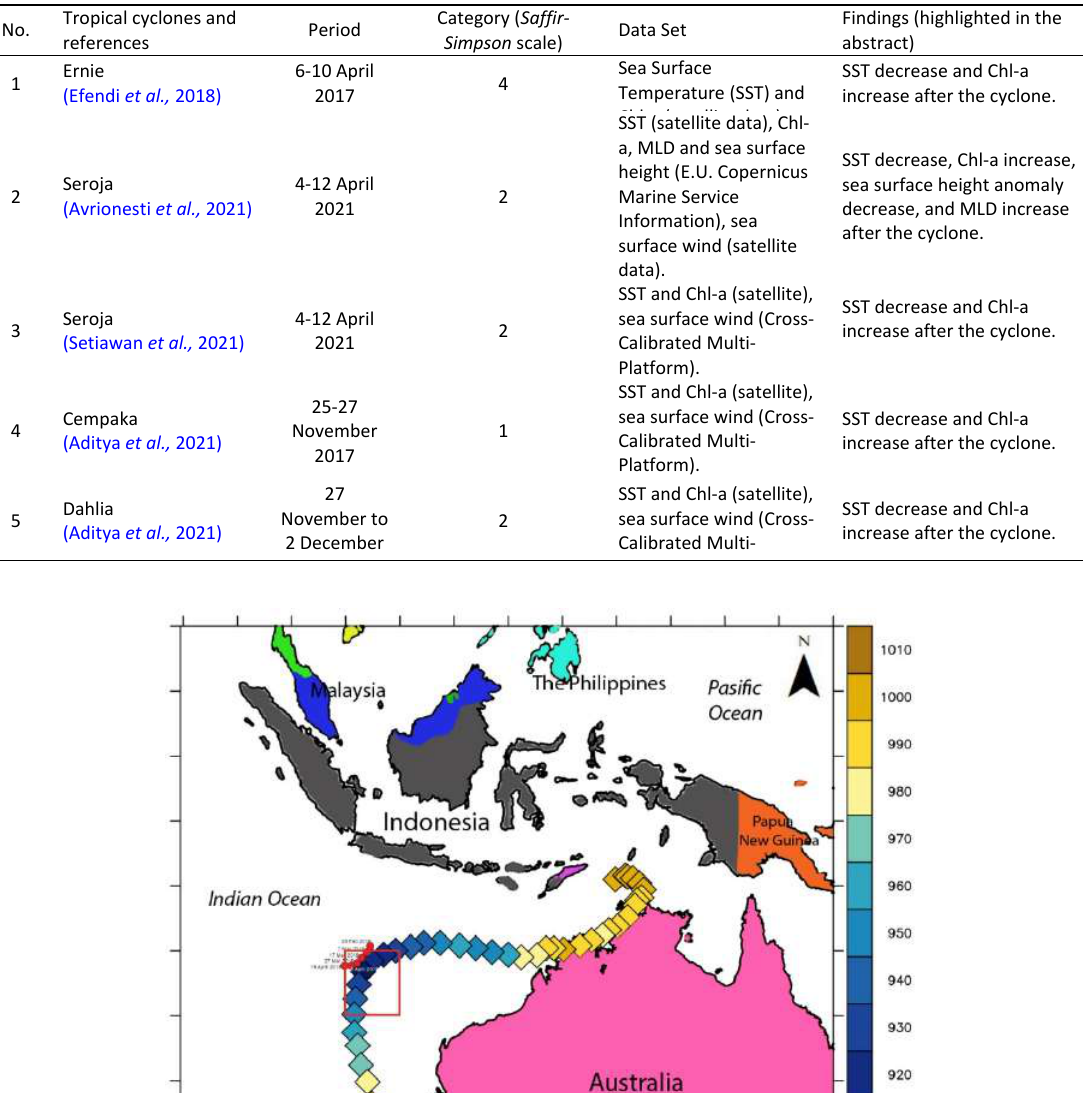
Table 1: Previous studies in the Southeastern Indian Ocean